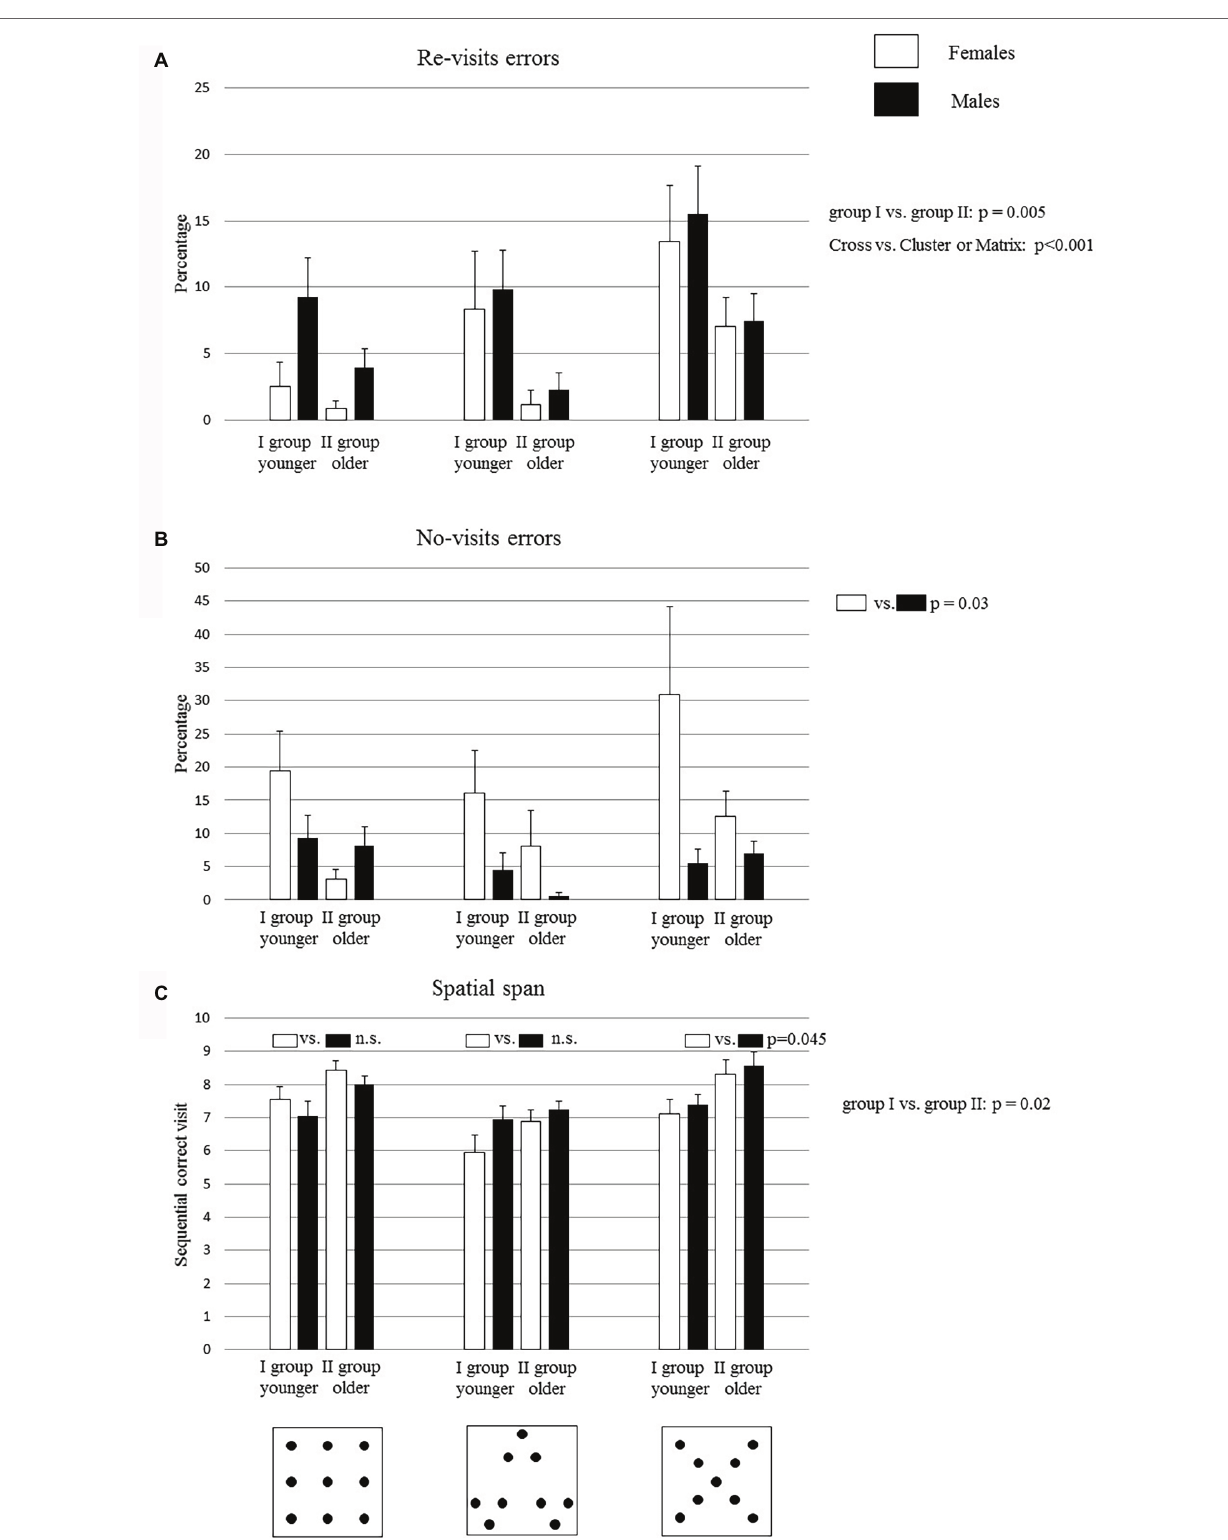
FIGURE 2 | Performances of group I and group II on the search task in Matrix, Cluster, and Cross configurations. Bucket arrangement in the three configurations is depicted in the figures below the graphs. Data are presented as mean ± SEM (A,B,C) . The p values inside the graph (C) indicate the significance level of post hoc comparisons on the second-order interaction. The p values of the main factors are reported on the right side of each